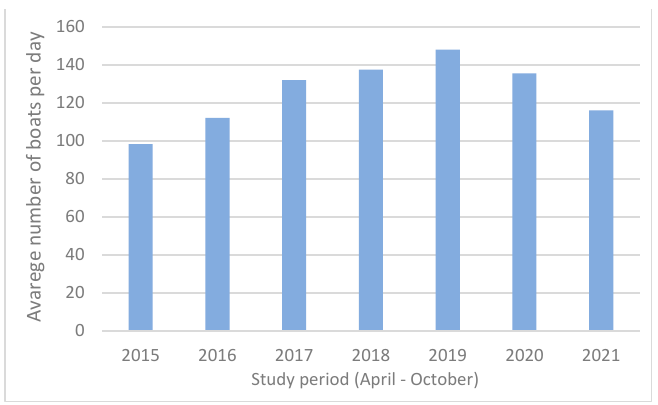
Figure 8. Daily average number of detected recreational boats for the period 2015–2021.